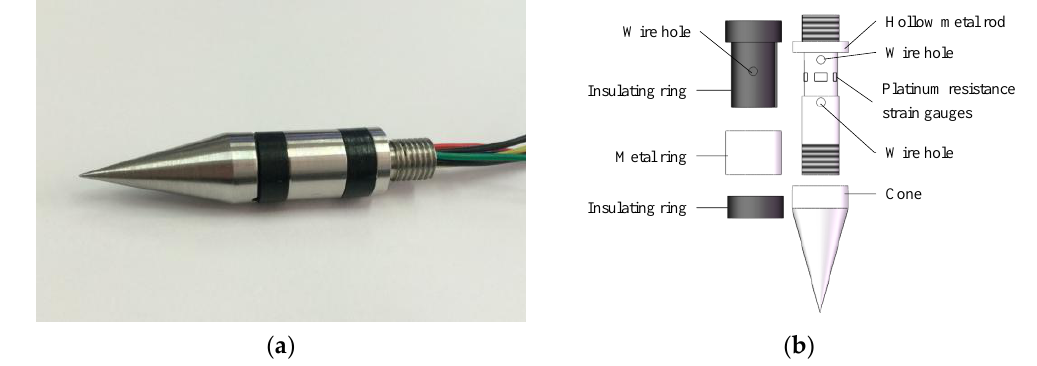
Figure 2. The probe of the compound sensor. ( a ) A photo of the probe; ( b ) Detailed structure of the probe.